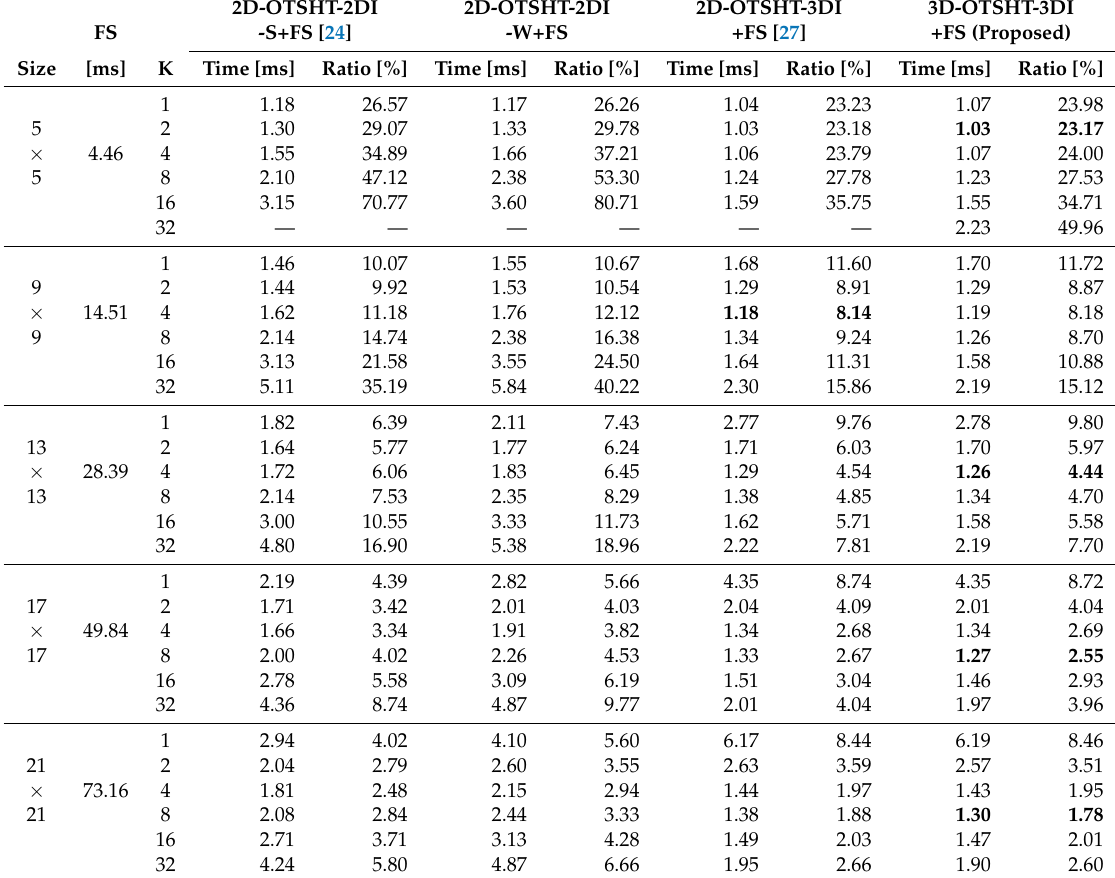
Table 3. Mean elapsed time and ratio to full search (FS) time in color images of size 256